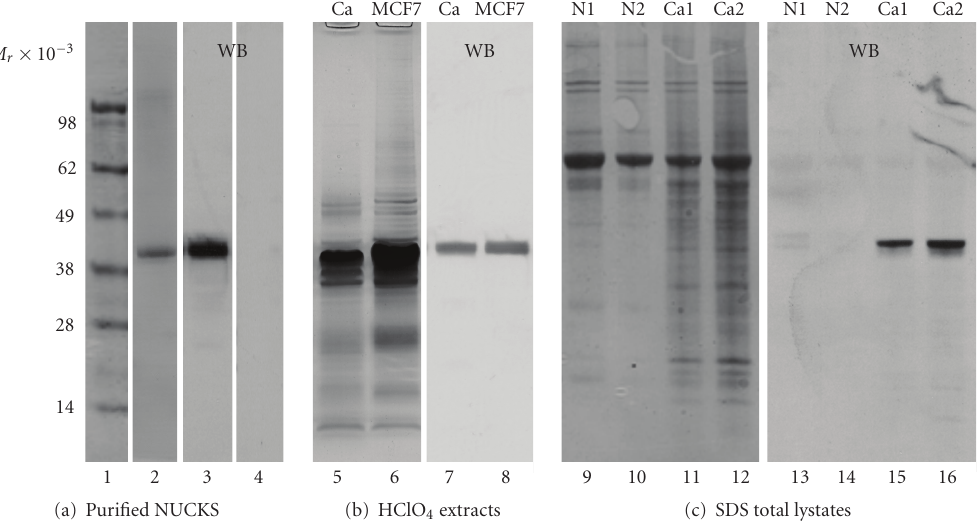
Figure 2: Specificity of the antibodies elicited against NUCKS’ peptide: Purified NUCKS ((a) lanes 2–4), HClO4-extracts invasive ductal carcinoma GII (Ca in (b): lanes 5 and 7) and MCF 7 cells ((b): lanes 6 and 8), and SDS-total lysates of normal breast (N: lanes 9, 10, 13, 14) and invasive ductal carcinoma GII (Ca in (c): lanes 11, 12, 15, 16) each matching the same patient (c) were separated by SDS-PAGE, blotted onto nitrocellulose and incubated with a ffi nity purified anti-NUCKS antibodies. Lane 4: the antibodies were preincubated with the peptide used for antibody production and purification. Total protein was stained on blots with Amido Black (lanes 1, 2, 5, 6, and